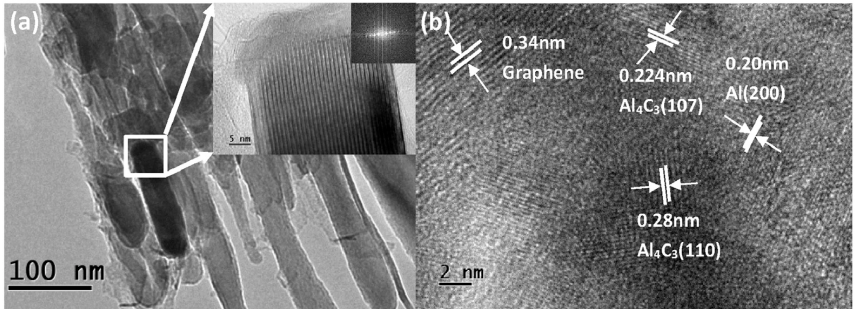
Figure 5. Transmission electron microscopy (TEM) and high-resolution transmission electron microscopy (HRTEM) images of Al/GNPs composites: ( a ) TEM image shows rod aluminum carbide with corresponding selected area diffraction (SAED) patterns, ( b ) graphene, Al, aluminum carbide area and their interface [121], Reproduced from [121], with permission from Elsevier, 2018.